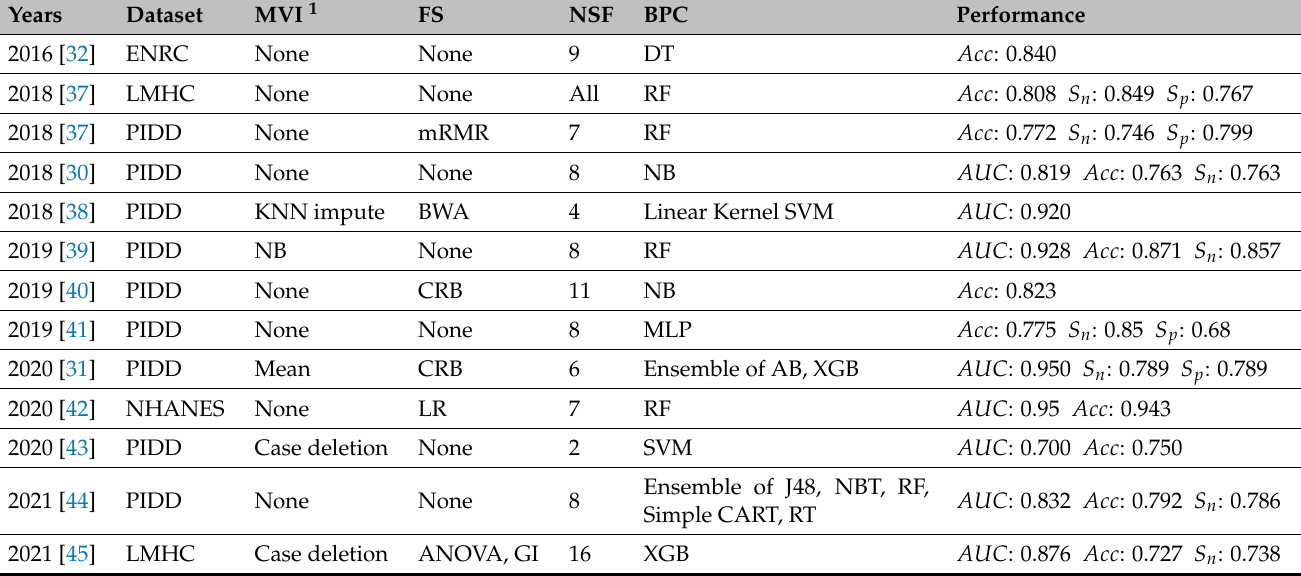
Table 1. Overview of different ML-based methods utilized in the previous literature for diabetes prediction, including the year of publication, used dataset, missing value imputation techniques, fea- ture selection strategies, number of selected features, classifier used, and corresponding performance evaluation